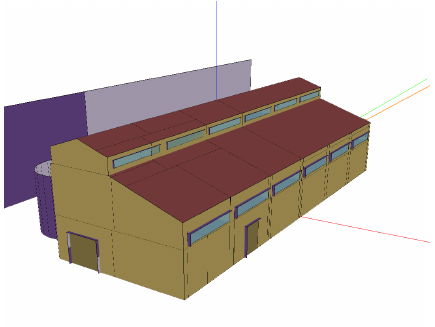
Figure A3. Envelope of the MixedUse